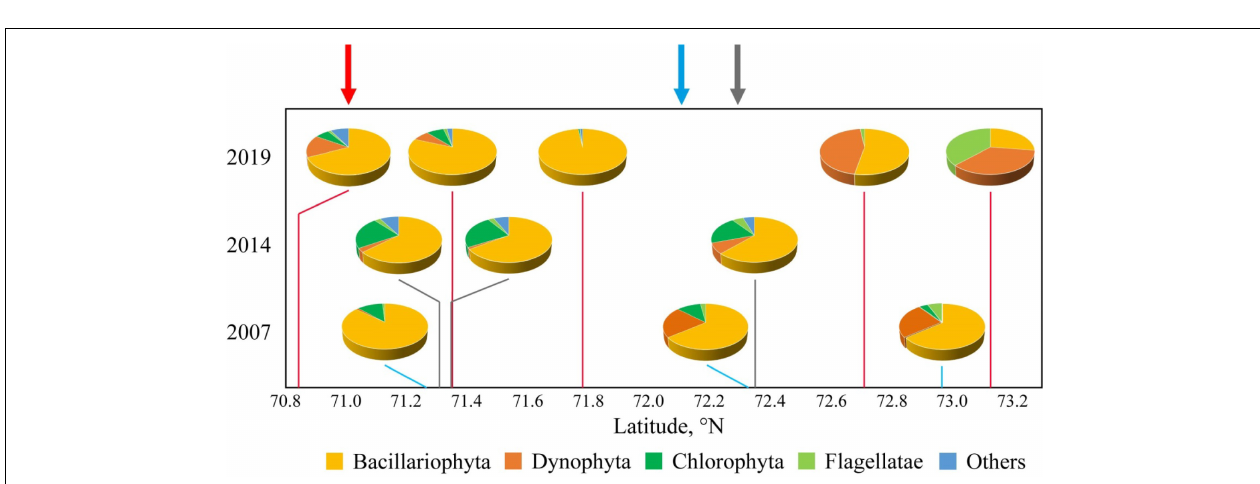
FIGURE 13 | Taxonomical structure of phytoplankton communities in 2007 (blue), 2014 (gray), and 2019 (red) at different zones within the Gulf of Ob. Arrows indicate southernmost detected locations of the isohaline of five in the bottom layer of the Gulf of